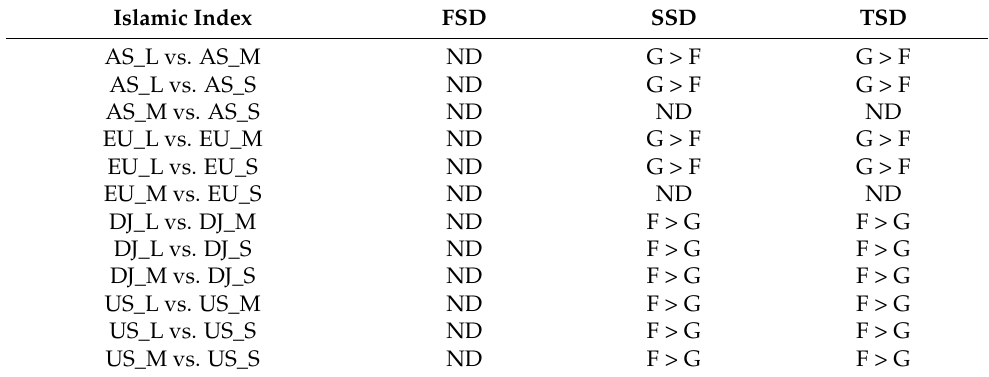
Table 2. Ascending Stochastic dominance (ASD) results of Davidson and Duclos test (1996–2019).